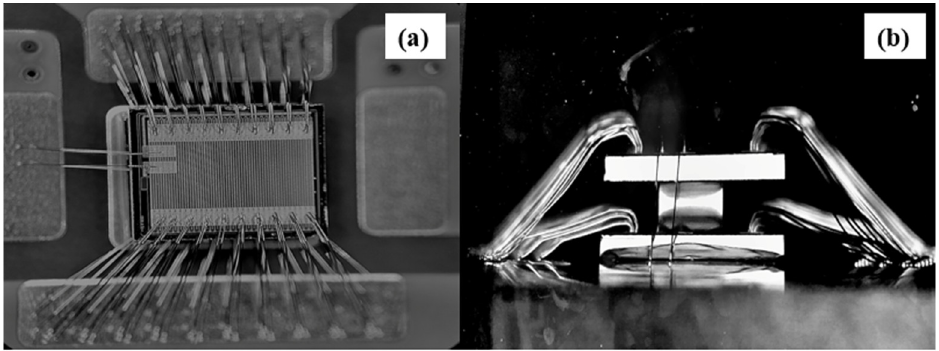
Figure 2. ( a ) Top view of stacked GaN MISHEMT, ( b ) side view of stacked GaN MISHEMT.